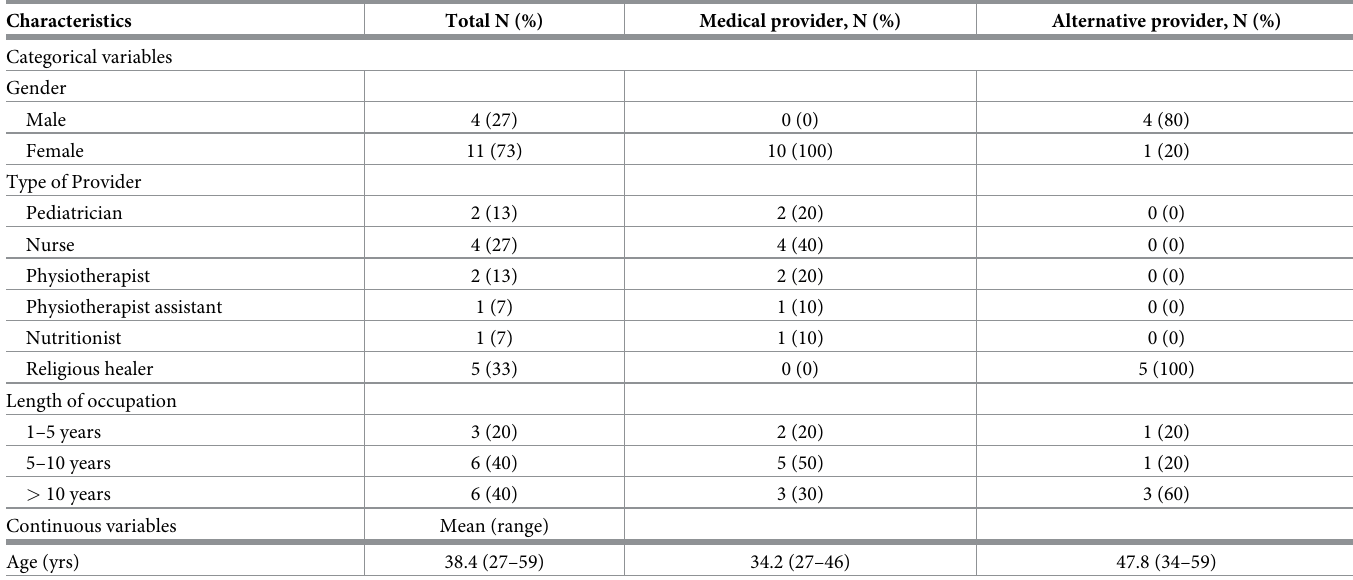
Table 3. Background characteristics of providers, N = 15.